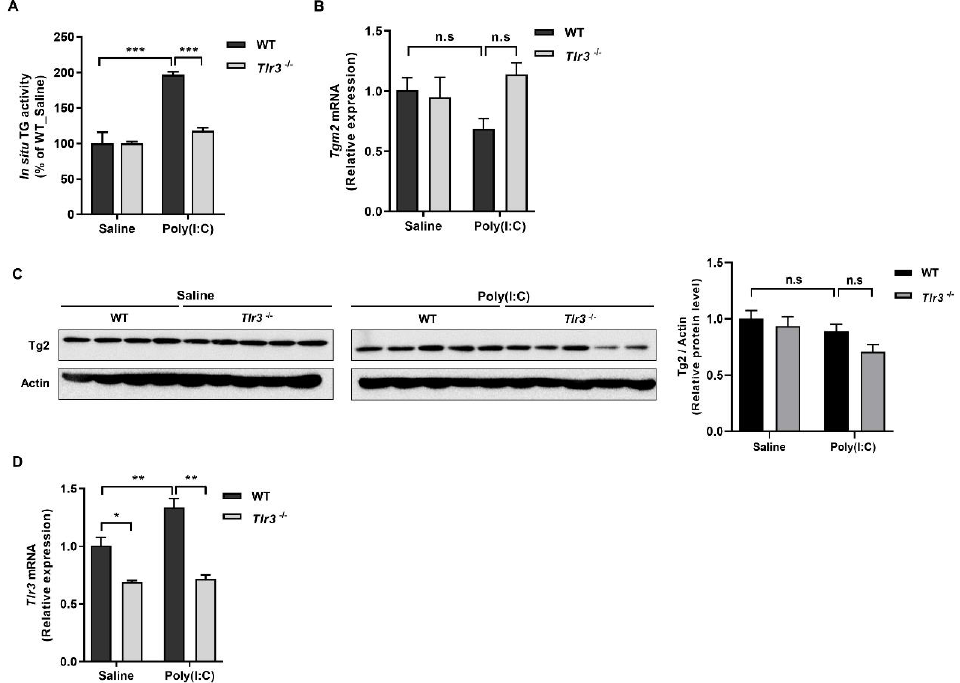
Figure 3. Tlr3 is required for poly(I:C)-induced Tg2 activation in MDFs. ( A – D ) Wild-type and Tlr3 − / − MDFs were treated with 20 µg/mL of poly(I:C) for 9 h. Intracellular TG activity was measured using biotinylated pentylamine (BP) incorporation assay (( A ), n = 3). mRNA level of Tgm2 and protein level of Tg2 were measured using qRT-PCR (( B ), n = 3) and western blotting ( C ), respectively. The ratio of Tg2 to Actin was estimated by densitometric analysis of Western blot ( C , right). mRNA level